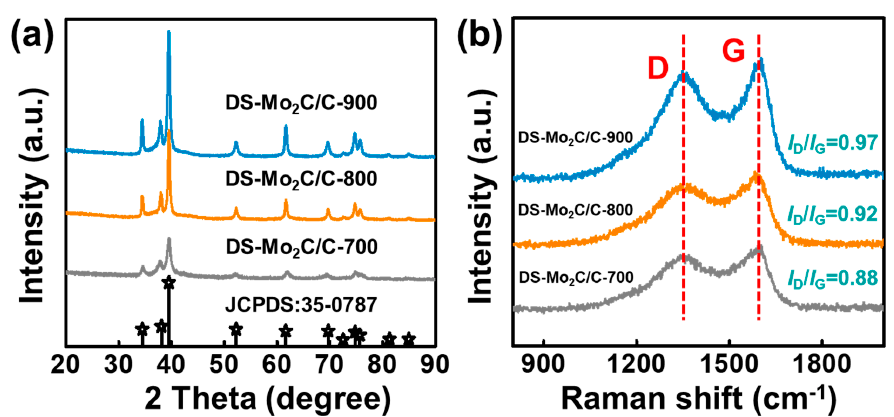
Figure 3. XRD patterns ( a ), Raman spectra ( b ) of DS − Mo 2 C/C.